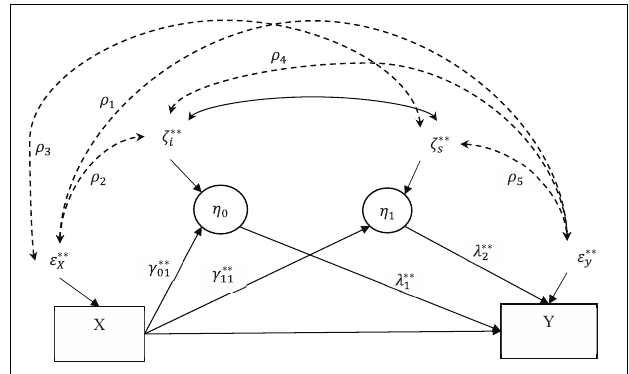
FIGURE 2 | Correlated augmented LGCMM. The antecedent variable ( X ) was pain at 4 months after treatment. The two covarying mediators were the latent intercept ( η 0 = mean negative mood at 4 months) and slope ( η 1 = monthly rate of negative affect) for the repeated measures of negative affect. The outcome variable ( Y ) measures percent drinking days (PDD) at 16 months. A single-headed arrow shows the direct effect of a variable at the origin on the variable at the end of the arrow. A solid double-headed arrow shows covariance between the two residuals. A dashed doubled headed arrow shows confounder covariance (correlation) between the